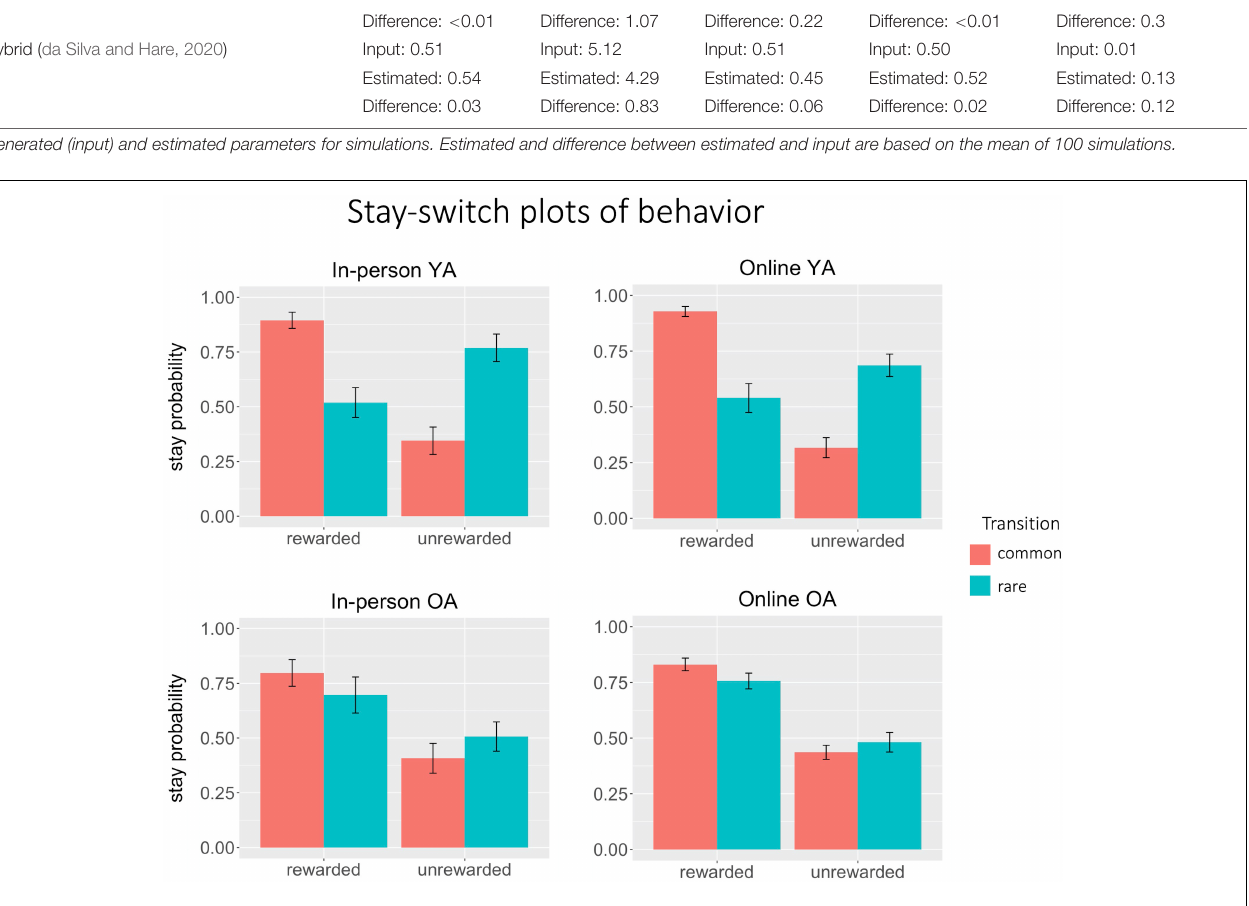
FIGURE 3 | Stay-switch plots of behavior. Both in-person ( n = 12) and online ( n = 30) young adult groups exhibited hybrid behavior, that is, a mix of model-based and model-free behavior. In both in-person ( n = 11) and online ( n = 30) older adult groups, behavior was more characteristic of habitual performance, with a strong effect of reward but an attenuated effect of